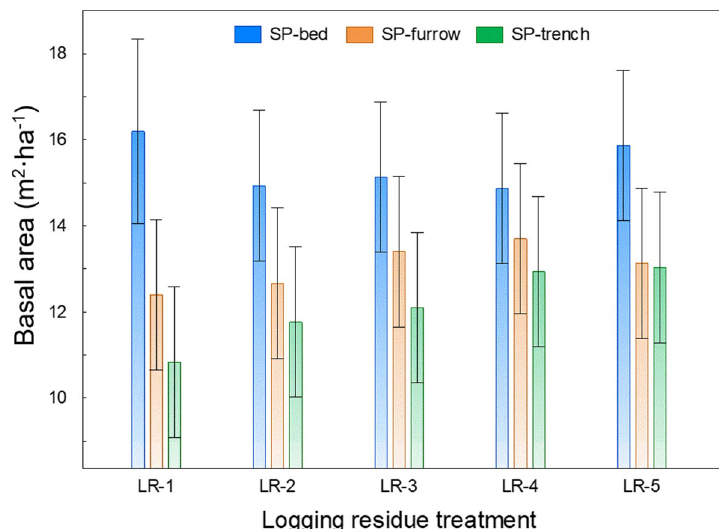
Fig. 5 Mean ( 95% confidence interval) basal area (at 12 years of age) for five logging residue treatments: complete removal (LR‑1), incineration ± (LR‑2), leaving whole on surface (LR‑3), comminution and leaving on surface (LR‑4), and comminution and mixing with topsoil (LR‑5), and three methods of site preparation: bedding and planting on ridges (SP‑bed), plowing and planting in furrows (SP‑furrow), and disc trenching